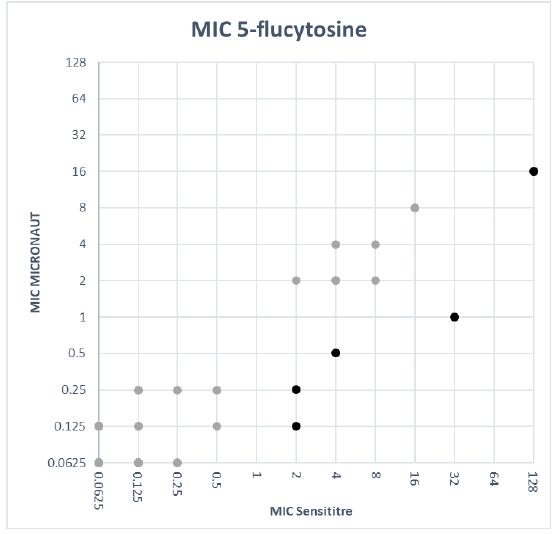
Figure 1. MIC values obtained with SY versus MIC values obtained with M-AM for each antifungal agent. The light colored dots represent MIC values within two dilutions between both methods. The dark colored dots represent MIC discrepancies of more than two dilutions.